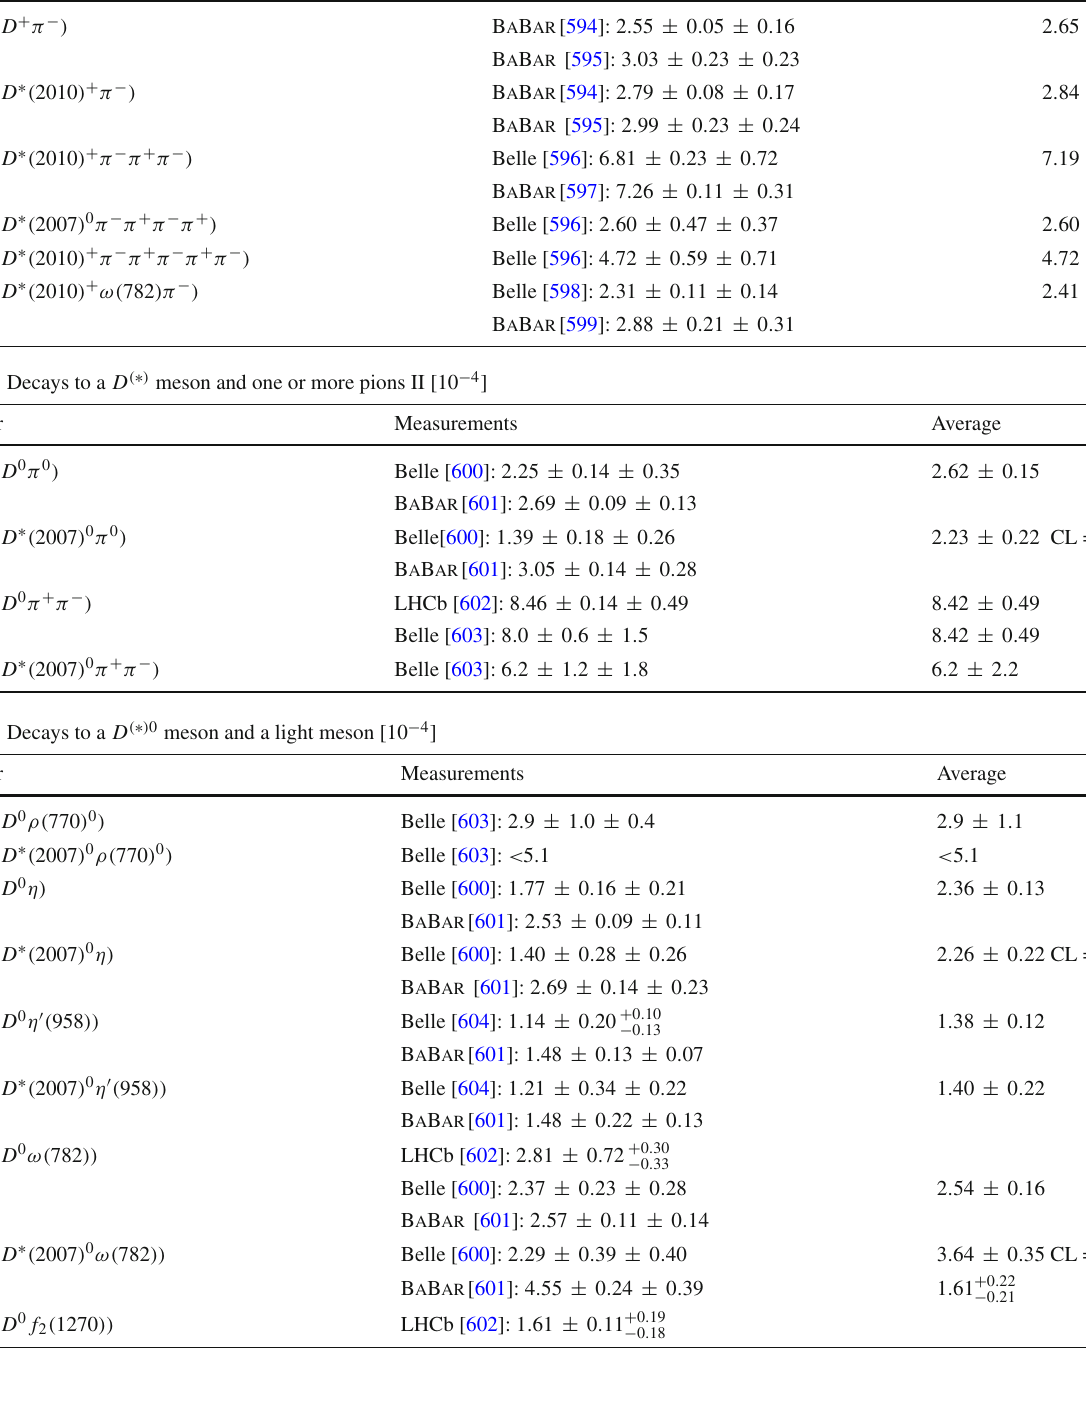
Table 93 Decays to a D ( ∗ ) meson and one or more pions I [ 10 − 3 ] Parameter Measurements